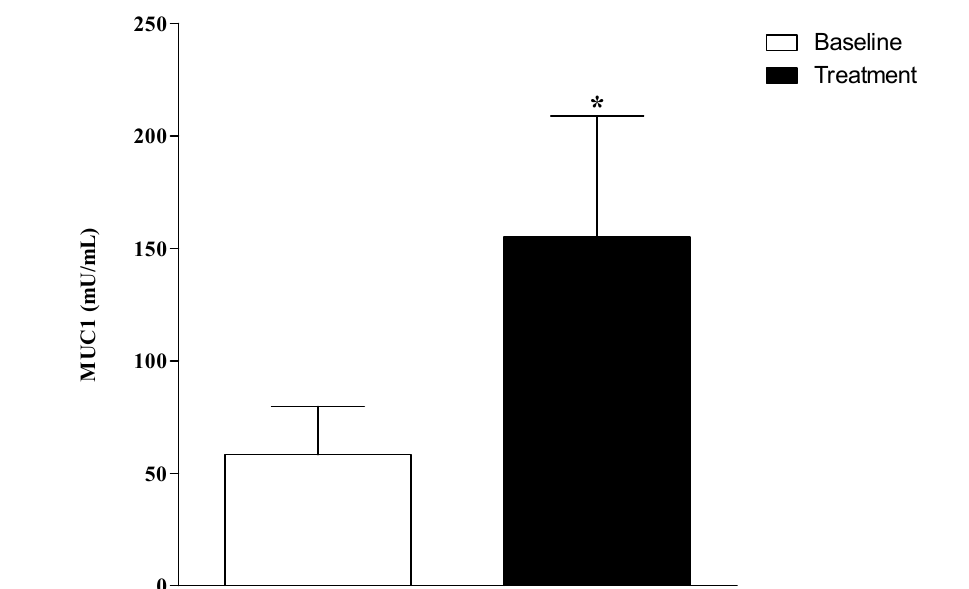
Figure 2. Salivary Mucin 1 (MUC 1) concentration at the baseline and after the treatment of denture- related stomatitis (DRS).